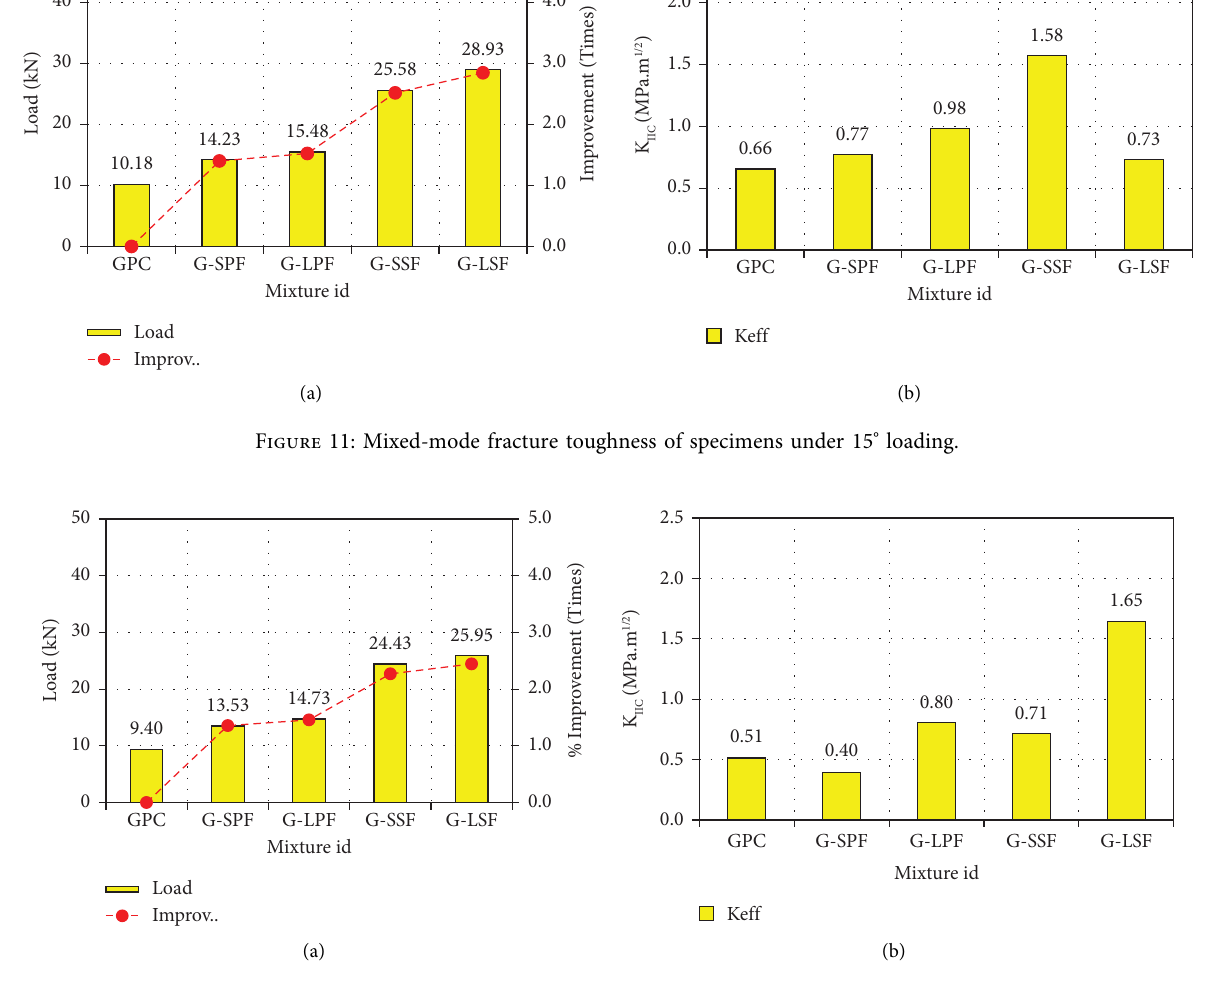
Figure 12: Mixed-mode fracture toughness of specimens under 45 ° loading.